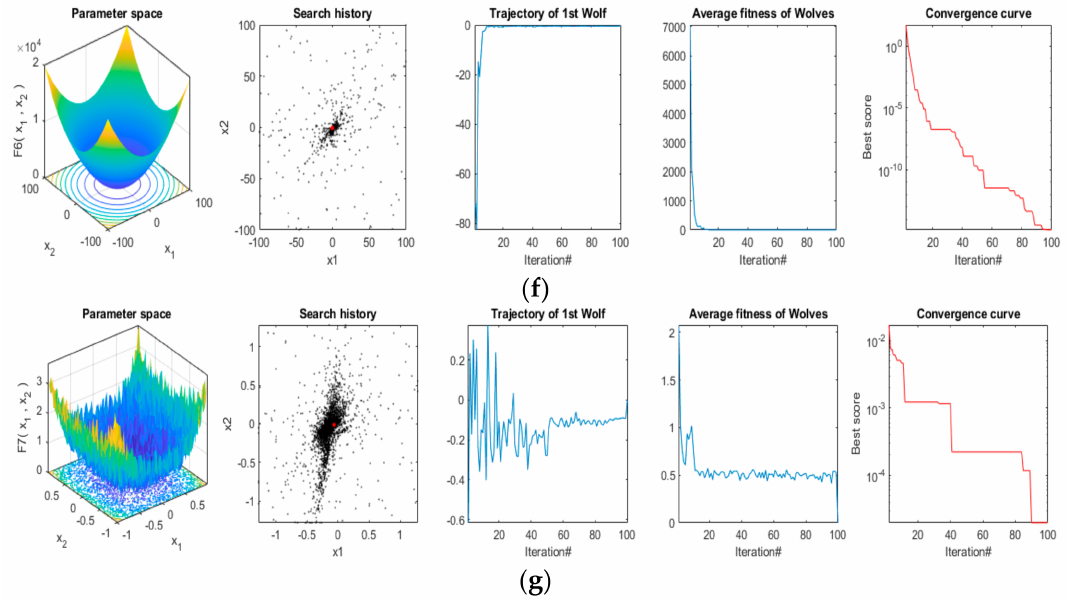
Figure 4. Parameter space, search history, trajectory of 1st wolf, the average fitness of all wolves, and convergence curve of NGWO for unimodal functions (F 1 –F 7 ). Here, ( a ) represents benchmark function F 1 , ( b ) represents benchmark function F 2 , ( c ) represents benchmark function F 3 , ( d ) represents benchmark function F 4 , ( e ) represents benchmark function F 5 , ( f ) represents benchmark function F 6 , ( g ) represents benchmark function F 7 .